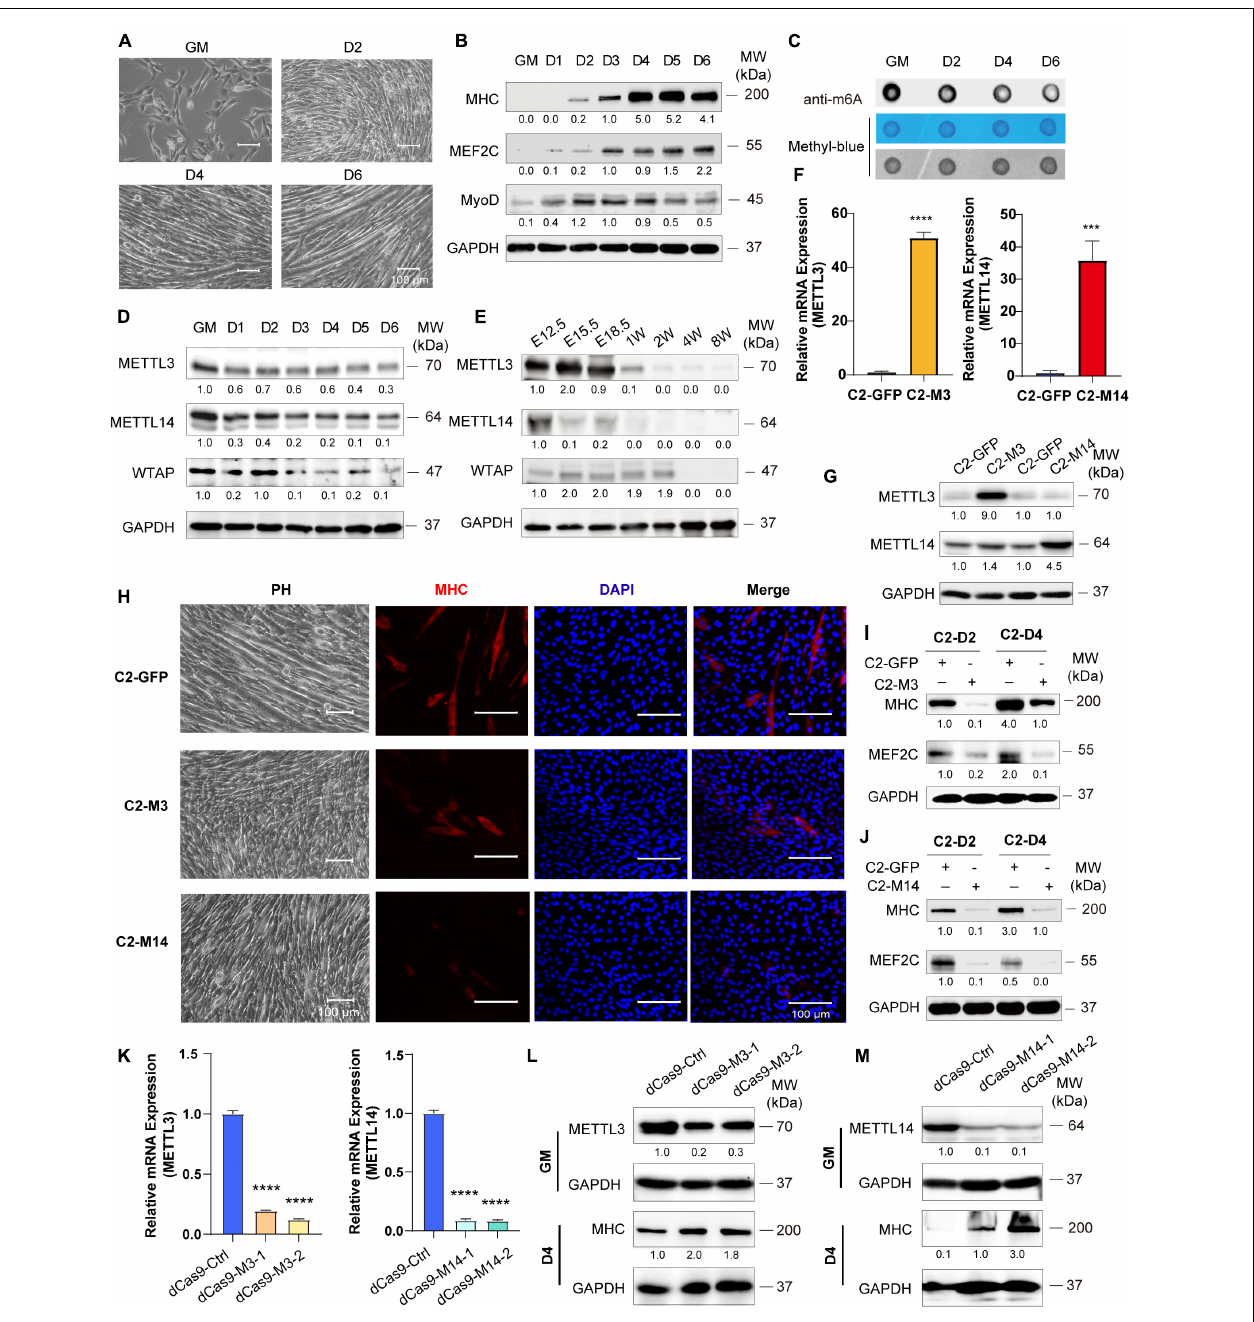
FIGURE 1 | Down-expression of Mettl3 and Mettl14 are required for skeletal muscle development. (A) Phenotype of differentiation C2C12 myoblasts in growth medium (GM) or day2 (D2), day4 (D4) or day6 (D6) in differentiation medium. (B) Western blot analysis of skeletal muscle differentiation markers MHC, MEF2C and MyoD of differentiation C2C12 myoblasts. (C) RNA dot blot assay of m 6 A methylation level of differentiation C2C12 myoblasts. (D) Western blot analysis of core components of m 6 A methyltransferases METTL3, METTL14 and WTAP in differentiating C2C12 myoblasts. (E) Western blot analysis of core components of m 6 A methyltransferases METTL3, METTL14 and WTAP during developing mouse embryos muscle differentiation. Mouse hind limb muscles were isolated from seven time points: E12.5, E15.5, E18.5 (embryos), postnatal 1 week, postnatal 2 weeks, postnatal 4 weeks, and postnatal 8 weeks (adult). The expression levels of METTL3 and METTL14 in the indicated METTL3- or METTL14- overexpressing C2C12 cells were determined by (F) Real-time PCR and (G) western blot. (H) Cell phenotype of the indicated C2C12 stable cells for differentiation 3 days. And immunofluorescent microscopy analysis of the expression of myogenic marker MHC in the indicated C2C12 stable cells for differentiation 3 days. The Scale bar indicated as 100 µ m. The expression of myogenic marker MHC and MEF2C in the indicated METTL3- (I) or METTL14- (J) overexpressing C2C12 stable cells upon differentiation for 2 or 4 days were detected by western blot. (K) Real-time PCR analysis of the RNA expression levels of METTL3 or METTL14 in the indicated METTL3/14 knockdown C2C12 stable cell lines. METTL3 or METTL14 were determined by western blot in indicated METTL3 (L) or METTL14 (M) knockdown C2C12 stable cell lines in GM, and myogenic marker MHC was determined in D4. Quantitative data was represented as Mean ± SD. *** p < 0.001, **** p < 0.0001.